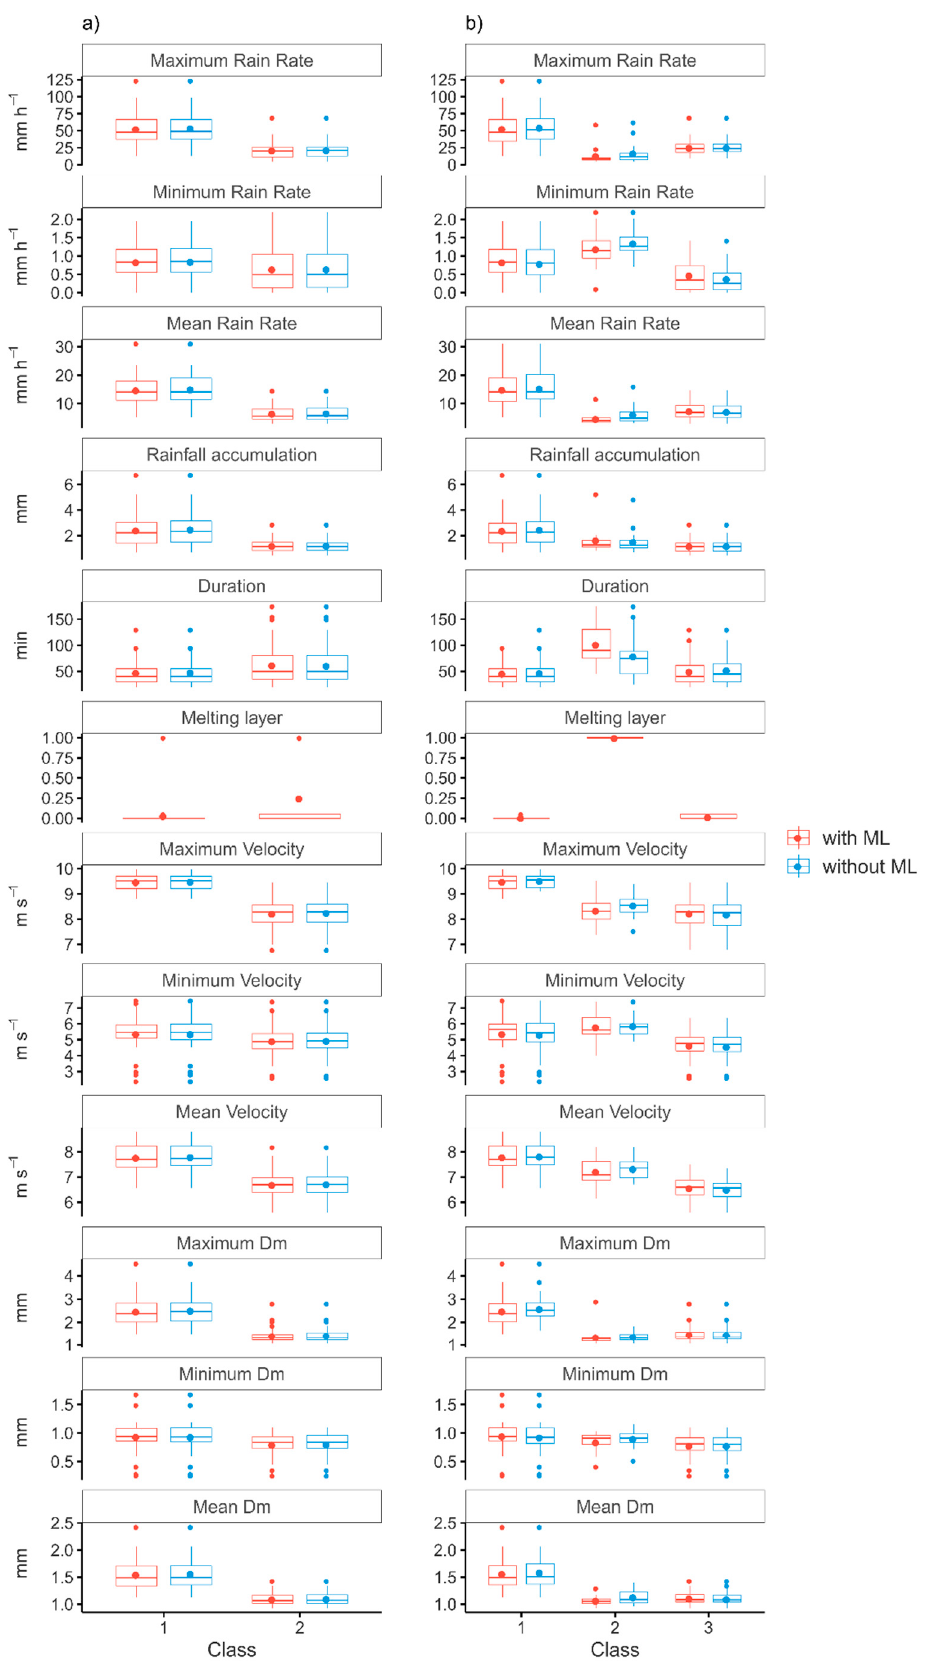
Figure 9. Boxplots of variables: ( a ) two classes, ( b ) three classes.